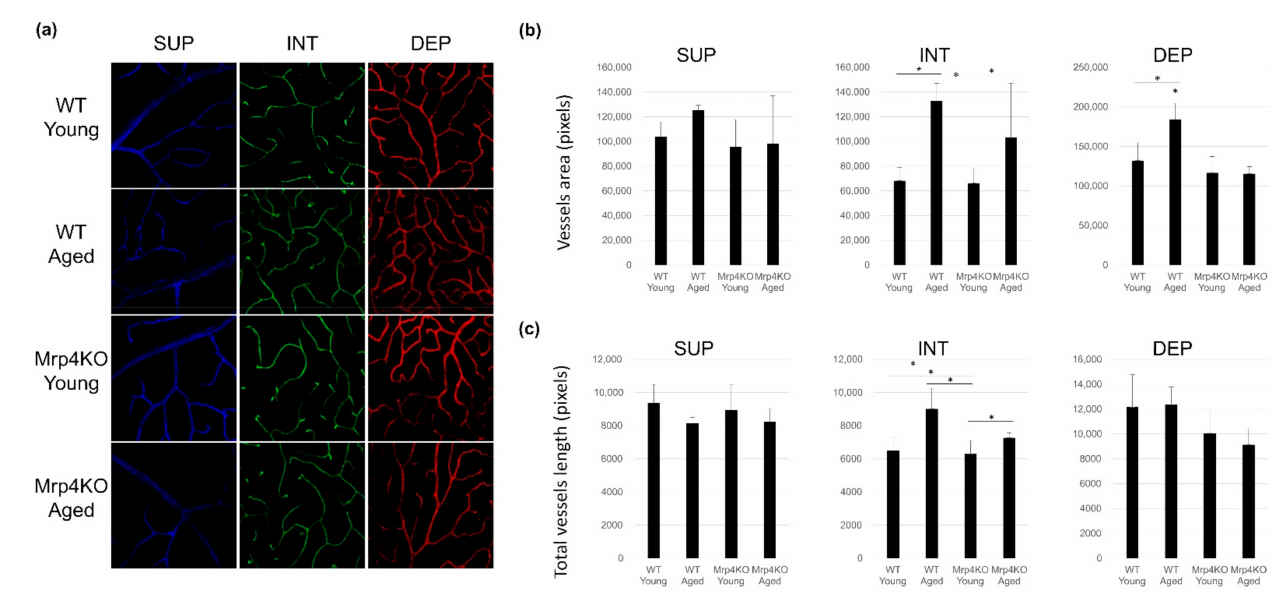
Figure 6. Retinal vasculature at the different levels of the retinal layer. ( a ) Representative images (x20 objective). ( b ) Quanti- tative comparison of vessel area in each retinal layer ( n = 3–4). ( c ) Quantitative comparison of the total vessel length in each retinal layer ( n = 3–4). WT, wild-type mice; Mrp4KO, Mrp4-null mice; GFAP, glial fibrillary acidic protein; SUP, superficial